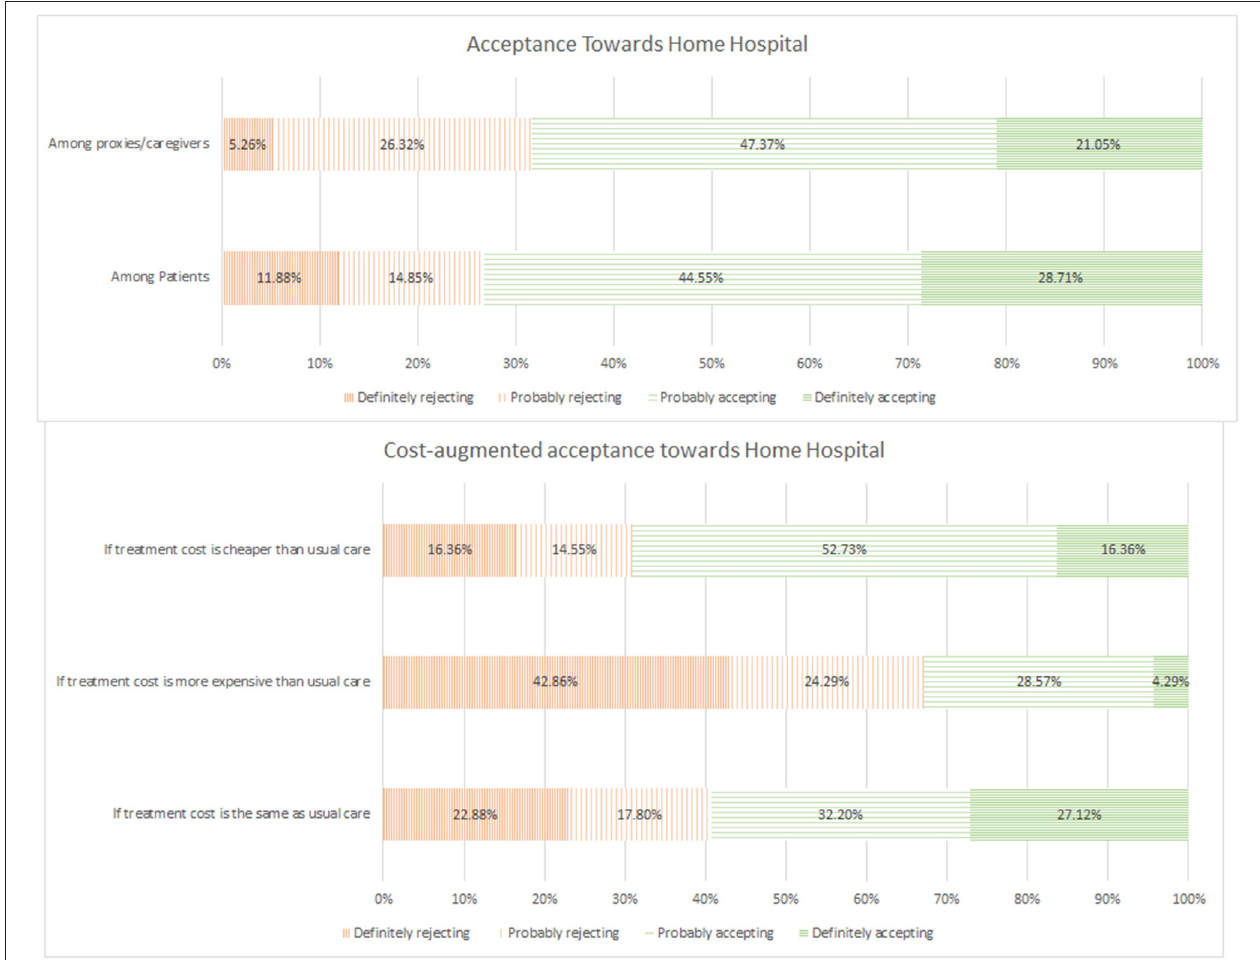
FIGURE 1 | Acceptance toward home